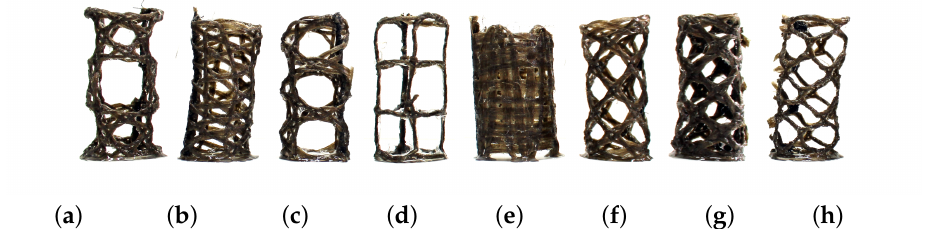
Figure 6. Cured lace samples for physical testing. From left to right: ( a ) A la Vierge, ( b ) Grille, ( c ) Quadrille Croise, ( d ) Quadrille Simple, ( e ) Toile, ( f ) Torchon, ( g ) Double Torchon, ( h )